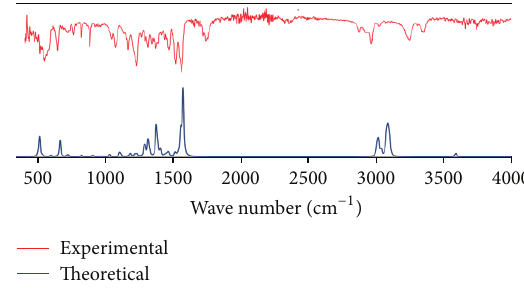
Figure 3: Comparative infrared spectra of the title compound in the gaseous state (theoretical, calculated using B3LYP/6-311G method) and in the solid state